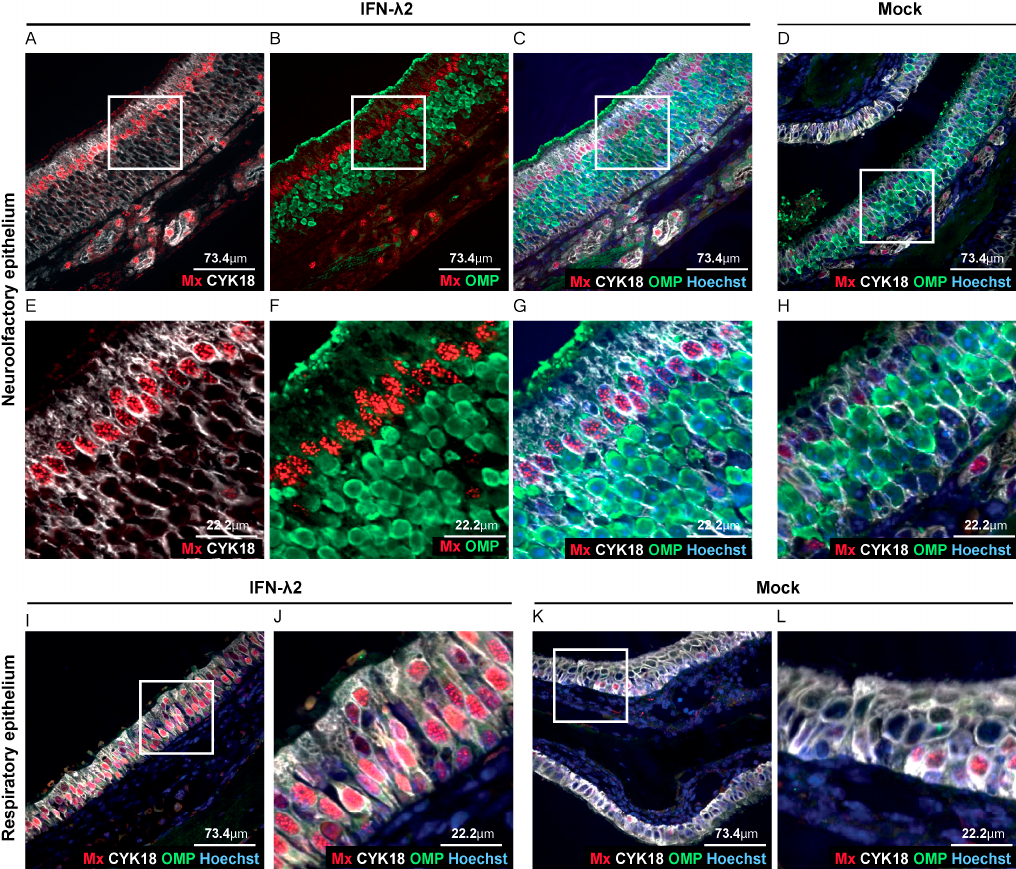
Figure 4. IFN- λ responsive cells in the olfactory epithelium. ( A – L ) Representative sections of the olfactory and respiratory nasal epitheliums labeled for Mx1 (red), olfactory marker protein (OMP) (neurons, green) and CYK18 (sustentacular cells, white). Where indicated, nuclei were stained with Hoechst dye (blue). Sections were from B6.A2G-Mx1-IFNAR1 –/– female mice, seven days after electroinjection of an empty plasmid ( n = 4) or a plasmid expressing IFN- λ 2 ( n = 4). ( A – C , E – G ) Representative sections of the olfactory epithelium of IFN- λ plasmid-treated mice revealing extensive Mx1 staining in sustentacular cells but not in neurons. ( D , H ) Little Mx1 expression in the olfactory epithelium of mock-treated mice. ( E – H ) Images zoomed-in from the upper panel (white square). ( I – L ) Extensive Mx1 expression in the respiratory epithelium of IFN- λ -treated mice ( I – J )